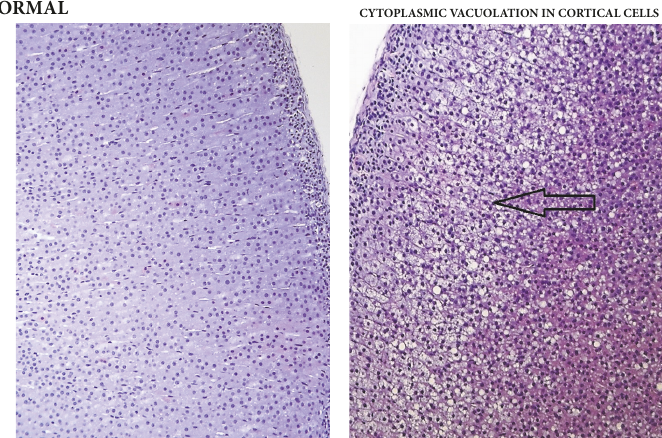
Figure 1: Adrenal cortex: comparison of normal (control) cortical cells to cells in a male from the 3000/4000 mg/kg bw/day group showing cytoplasmic vacuolation, 14-day study.